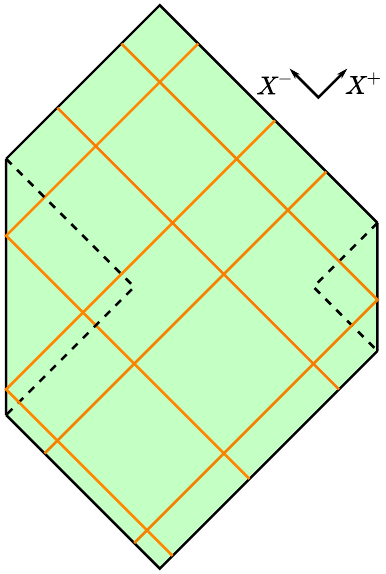
Figure 10 . A multi-shockwave configuration in JT gravity coupled to conformal matter. The shockwaves are solid orange lines, while the future/past horizons of the left and right boundaries are dashed black lines. Some shockwaves reflect off of the boundaries, while others live entirely in the wormhole